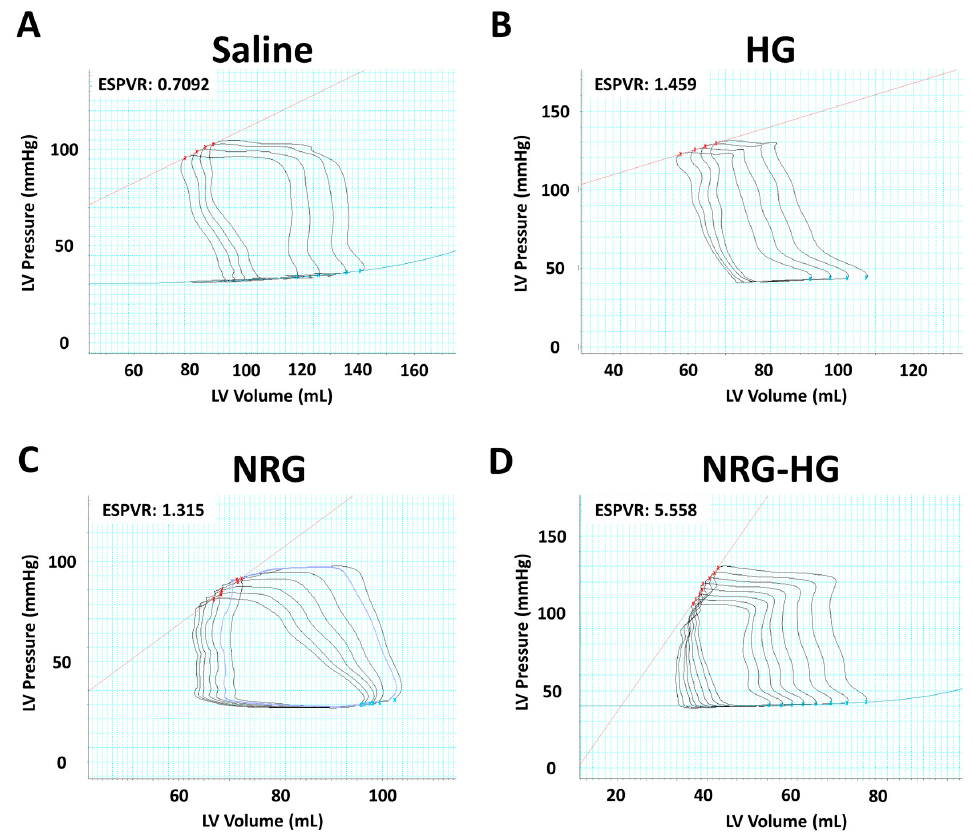
Figure 3. Representative pressure–volume loops for the ( A ) saline, ( B ) hydrogel only (HG), ( C ) neuregulin only (NRG), and ( D ) hydrogel-encapsulated neuregulin (NRG-HG) groups are shown. The slope of the end-systolic pressure-volume relationship (ESPVR, red line) is